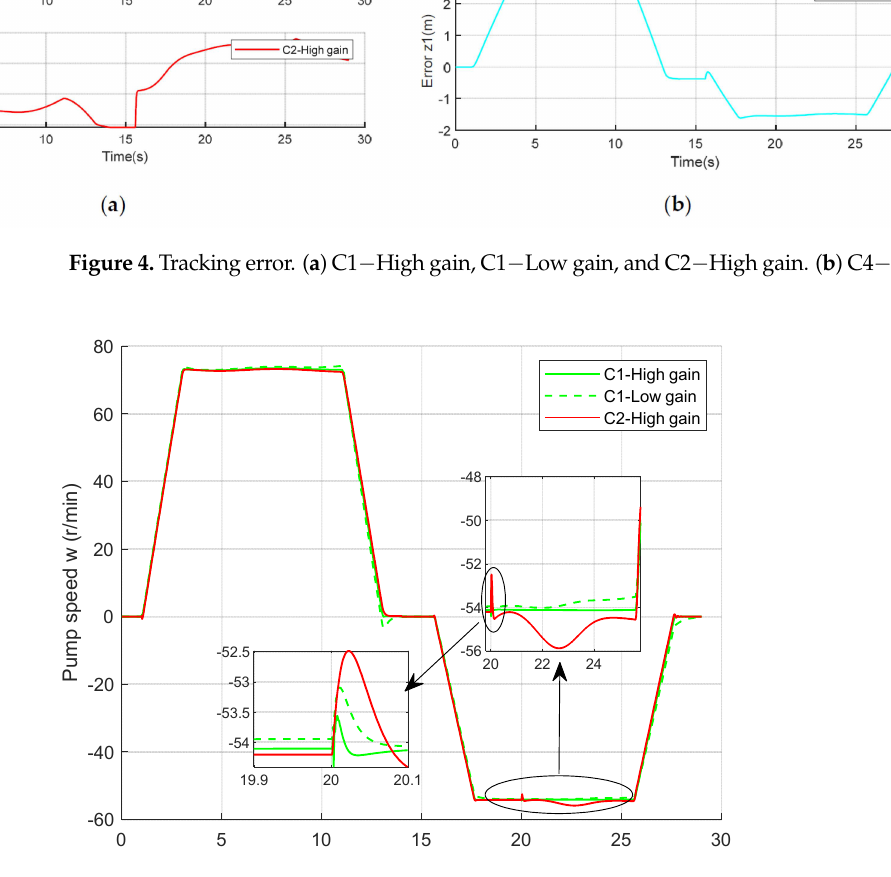
Figure 6. The external load